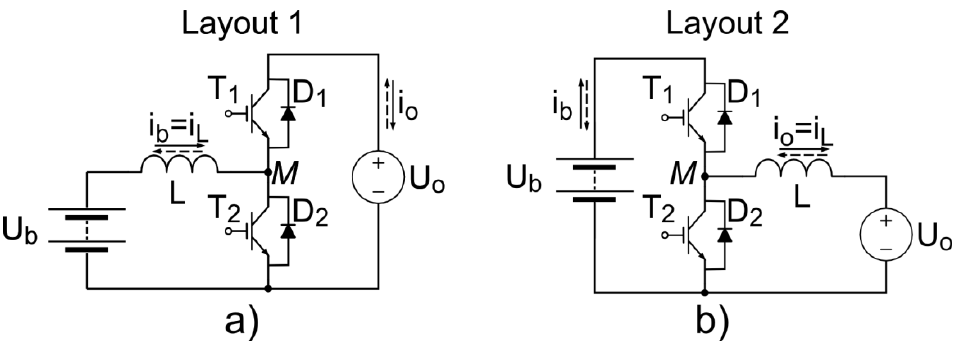
Figure 2. Main layouts of the d.c.-d.c. stage of the two-stage